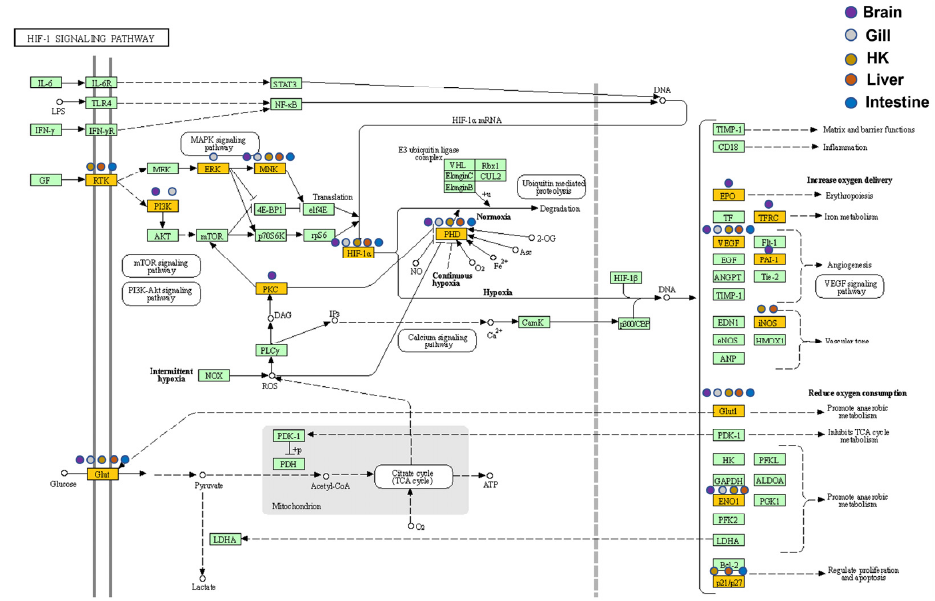
Figure 8. Expression patterns of the HIF-1 signaling pathway in five common carp organs: All target genes are colored in gold, and organ-specificity is shown at different points. Purple: brain, gray: gill, orange: head kidney (HK), red: liver, and blue: intestine. Table 4. Fold changes of oxygen-related genes expressed in the HIF-1 signaling pathway.